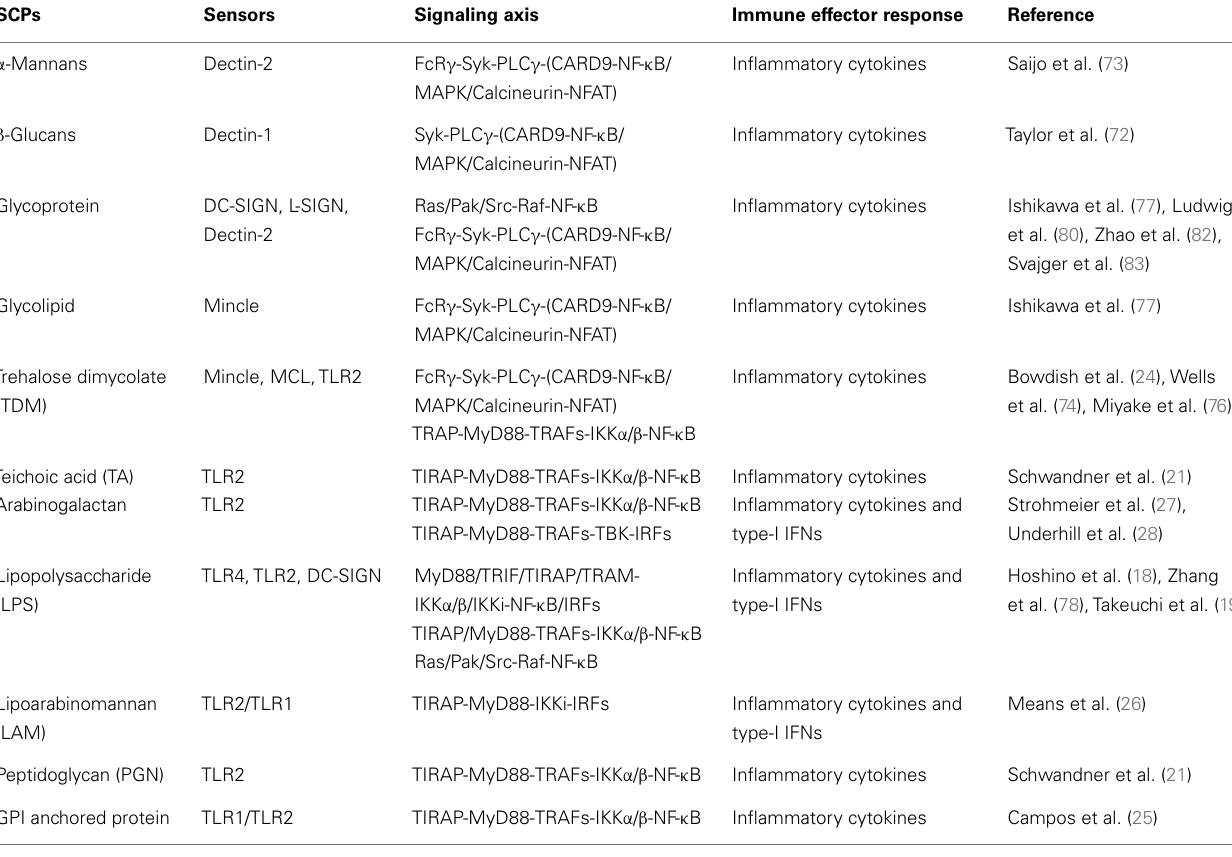
Table 1 | Sensing of SCPs by plasma membrane localized PRRs.